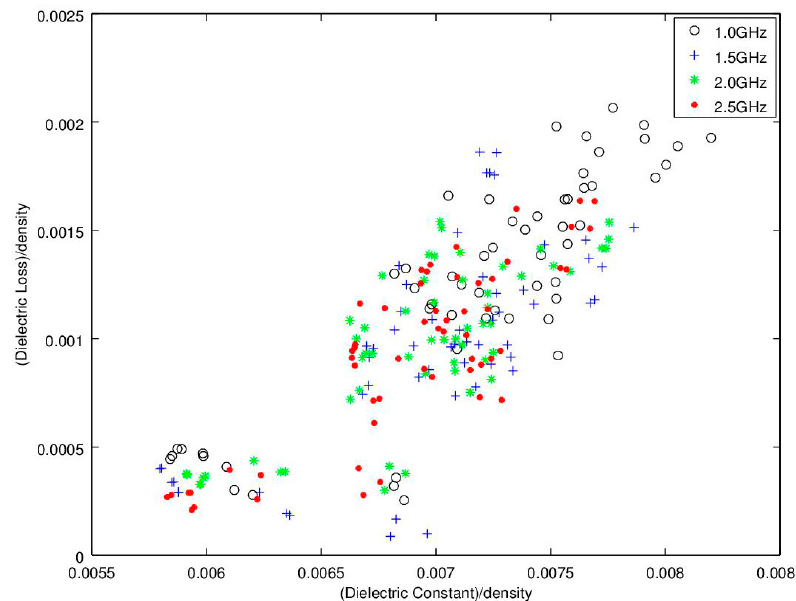
Figure 7. Detailed is a common approach showing the density-normalized Cole-Cole response as a function of frequency ( ε ’/ ρ and ε ”/ ρ ). Of interest is that previous researchers have reported this relation provides a linear output for agricultural seeds at higher microwave frequencies of 7, 11.3, 14.2, 18 GHz. Of importance is that, at this much lower frequency, the response shows a much higher degree of scatter and is therefore not likely to be useful for sensing moisture.